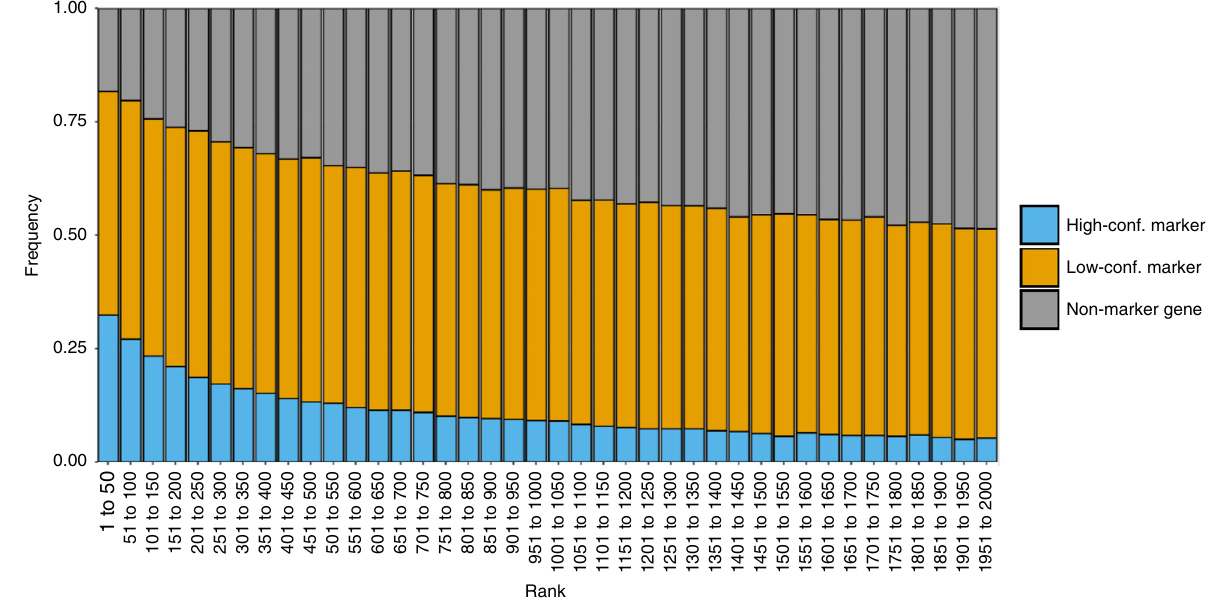
Fig. 5 Frequencies of cell type marker genes among DEGs. The frequencies of high-con fi dence (blue), low-con fi dence (orange), and non-marker genes (gray) among predicted DEGs in the 136 single-cell datasets are shown. The x -axis shows genes ranked by increasing p -value in bins of 50 (ranks 1 to 50, ranks 51 to 100, … , up to rank